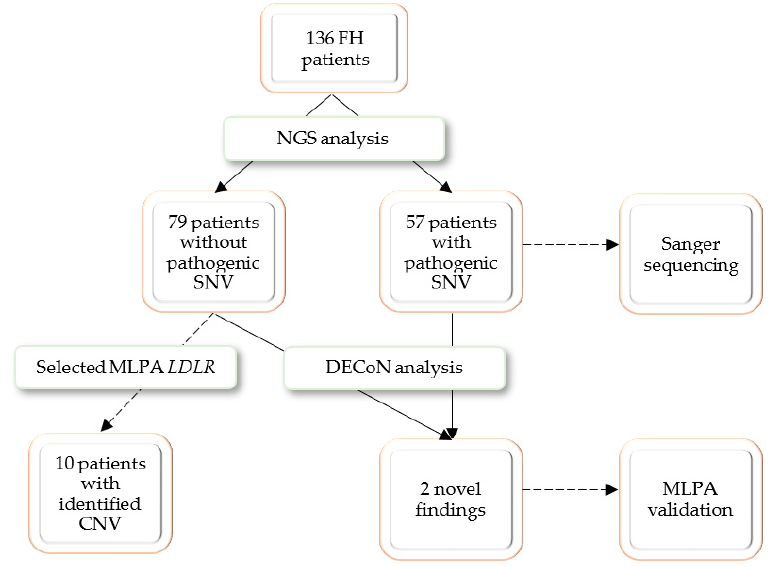
Figure 1. The schematic presentation of the conducted research.